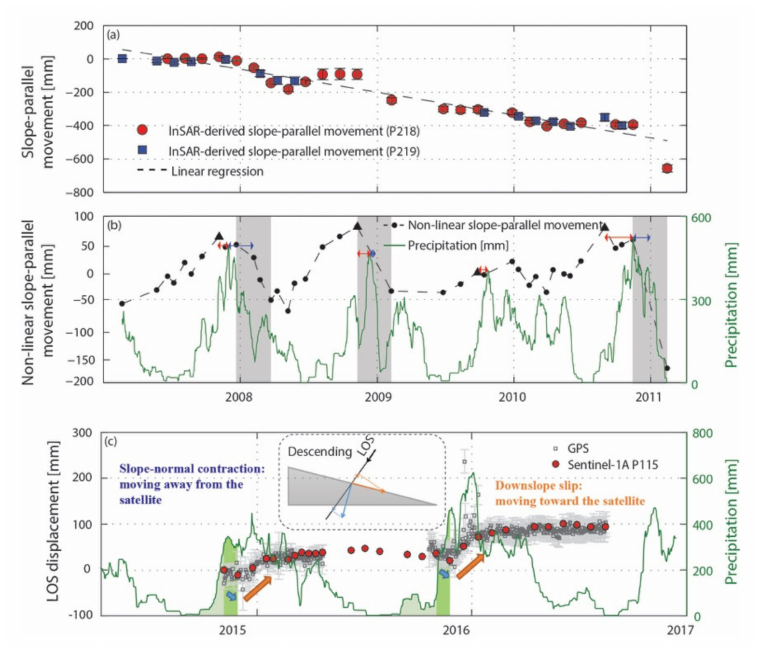
Figure 5. ( a ) Comparison of InSAR-derived slope-parallel movement derived from ALOS-1 tracks P218 (red circles) and P219 (blue squares) at a location on the active Crescent Lake landslide (red dot in Figure 3). The black dashed line denotes the linear regression of time-series displacement. ( b ) InSAR-derived non-linear slope-parallel movement (black dashed line; left axis) compared with the 30-day accumulated precipitation total (green line; right axis). Black triangles depict the initiation of downslope motion, red arrows show the gaps between the initiation of downslope motion and the precipitation peaks, gray bars indicate the sliding acceleration timespan that can be determined by the existing measurements, in which higher data sampling rate contributes to narrower bars and more precise estimates, and blue arrows show the gaps between the precipitation peak and the midpoint of sliding acceleration [42]. ( c ) Landslide displacements from a GPS station (red dot in Figure 1), which was temporally installed and operated by USGS, projected onto the LOS direction in comparison with the Sentinel-1A measurements from descending track P115, along with pre-30-day cumulative precipitation (summation of 30 daily precipitation before each date) from a nearby weather station. The light green shades under the pre-30-day precipitation curves show the antecedent rainfall period, and the dark green shading corresponds to the period of slope-normal subsidence when the precipitation is more intense. The inset diagram shows how ground displacement is sensed by a descending right-looking satellite track [46].